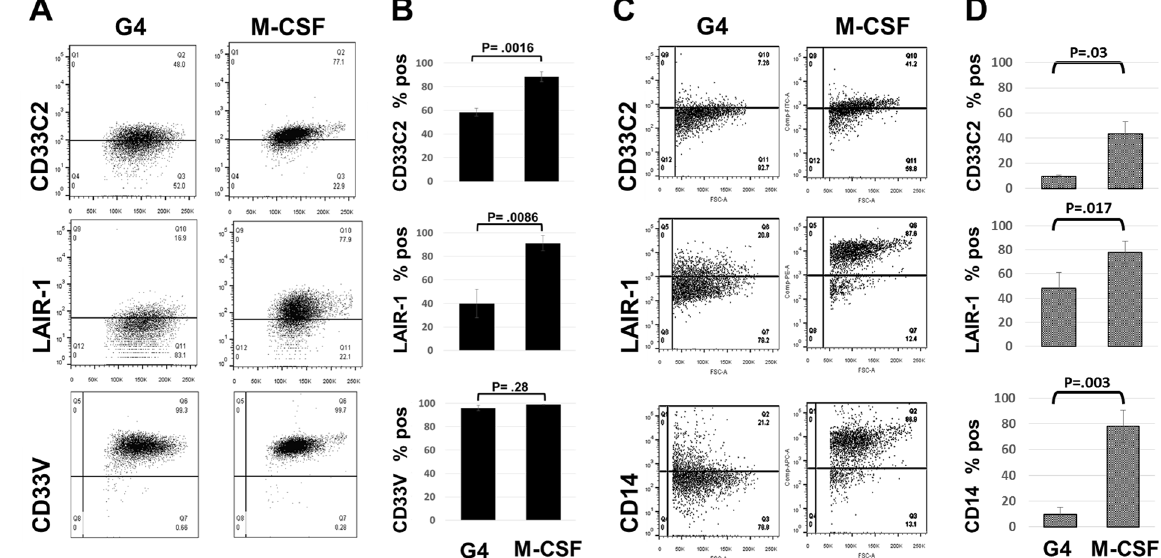
Figure 7. Myeloid cytokines distinctly control the coupled expression of CD33C2 and LAIR-1 in healthy and SLE cells. Freshly isolated adherent mononuclear cells from healthy subjects ( A , B ) and SLE patients ( C , D ) were cultured in parallel with either GM-CSF/IL-4 (G4) or M-CSF for 5 days, stained with anti-LAIR-1, CD33C2, CD33V antibodies and then analyzed by flow cytometry. ( A , C ): dot plots represent fluorescence versus forward light scatter patterns for a typical experiment; ( B , D ) represent the mean + / − SEM of pooled flow cytometry data. Two-tailed Student’s t test was used to determine significance. For normals, G4 vs M-CSF; N = 5 for CD33C2, N = 6 for CD33V, N = 4 for LAIR-1. For SLE, G4 vs M-CSF; N = 4 for CD33C2, LAIR-1; N = 3 for